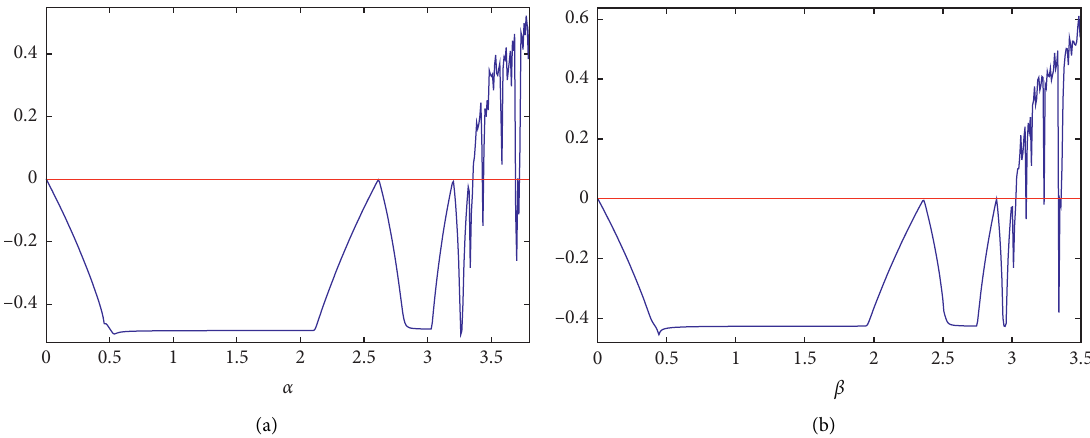
Figure 8: LLE diagram of the model with respect to α and β